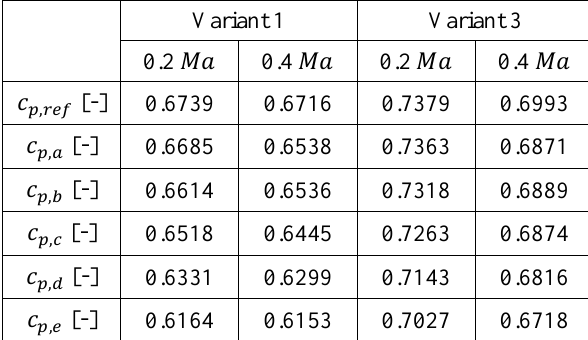
Table 8. Pressure recovery coefficient